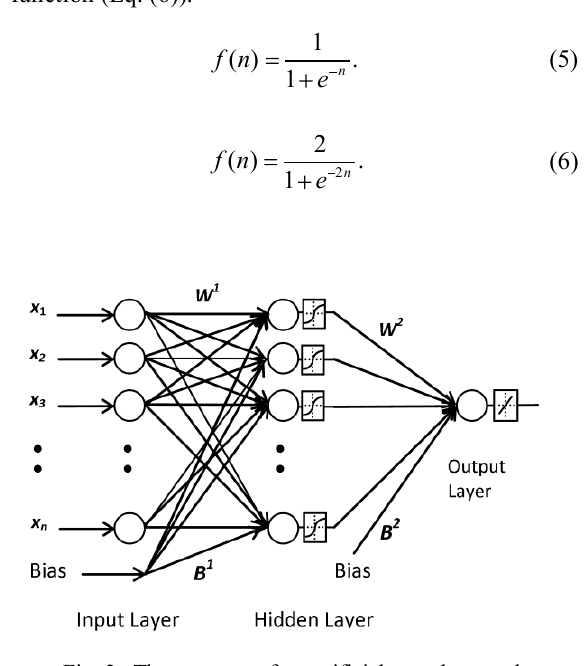
Fig. 2. The structure of an artificial neural network The network weights and bias can be optimized by